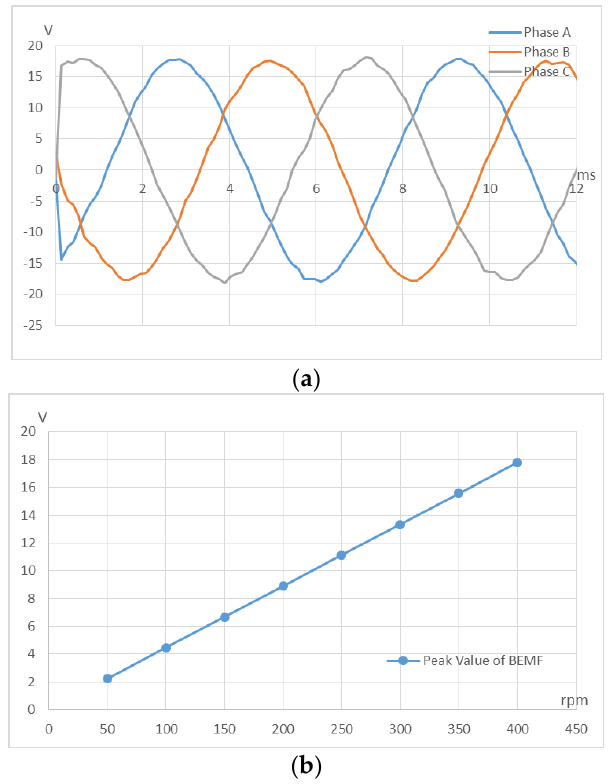
Figure 3. FEM analysis results. ( a ) No-load back-EMFs at 400 rpm; ( b ) Peak values of the back-EMFs.